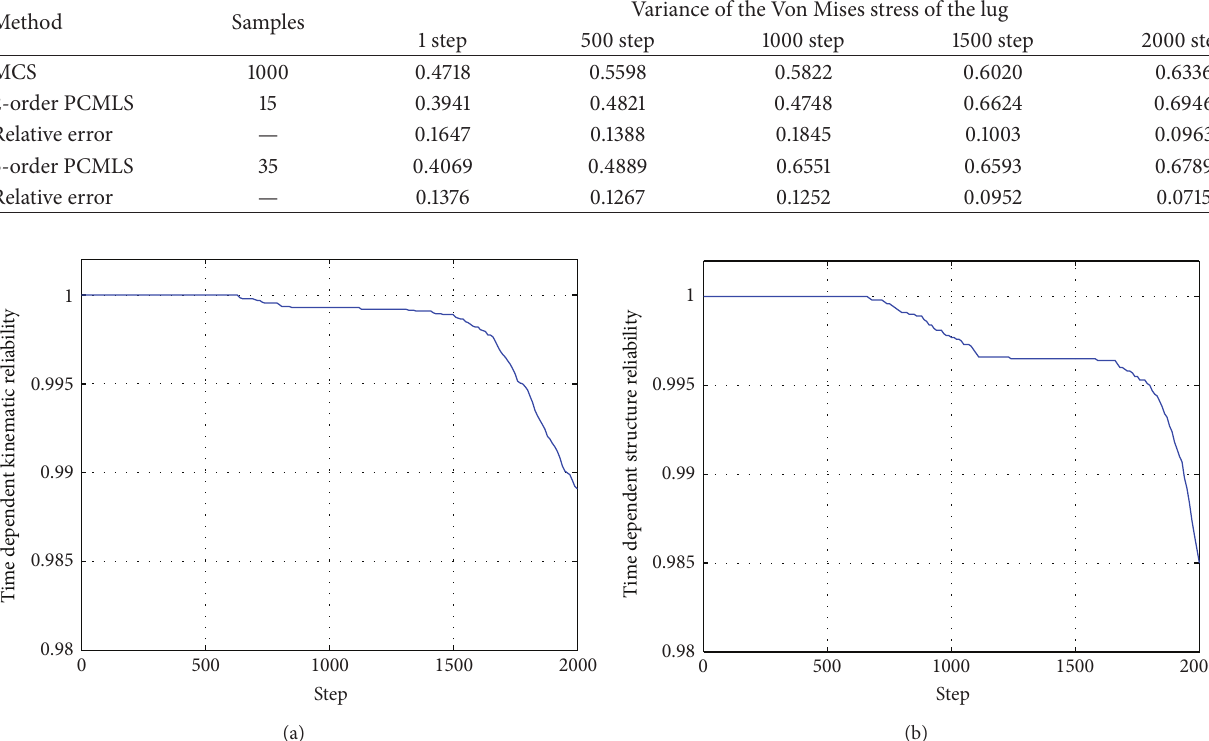
Figure 10: Time-dependent reliability computed through the PCMLS model. (a) Time-dependent kinematic reliability caused by the wear at the top hinge; (b) time-dependent structure reliability caused by the increase of stress of